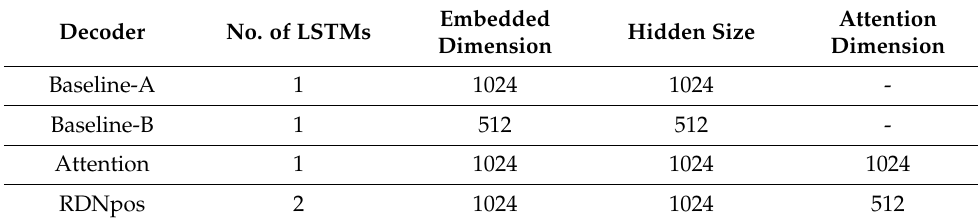
Table 1. Hyperparameters used during training.